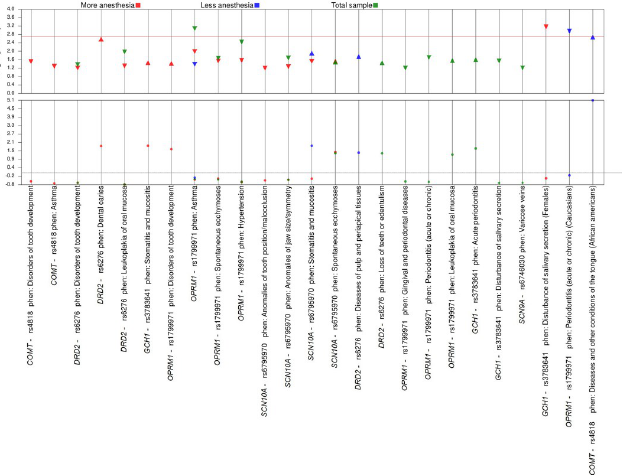
Fig 2. PheWAS results stratified across different groups. The color red represents a group of individuals that received more anesthesia. Blue represents a group that received less anesthesia, and green represents the total sample. The tip direction of the triangles represents the direction of the odds ratio of each association, the upward triangles indicate OR � 1; downward triangles indicate a protective effect (OR < 1.0). Nominal associations are showed under the horizontal red line that indicates threshold of p < 0.002.